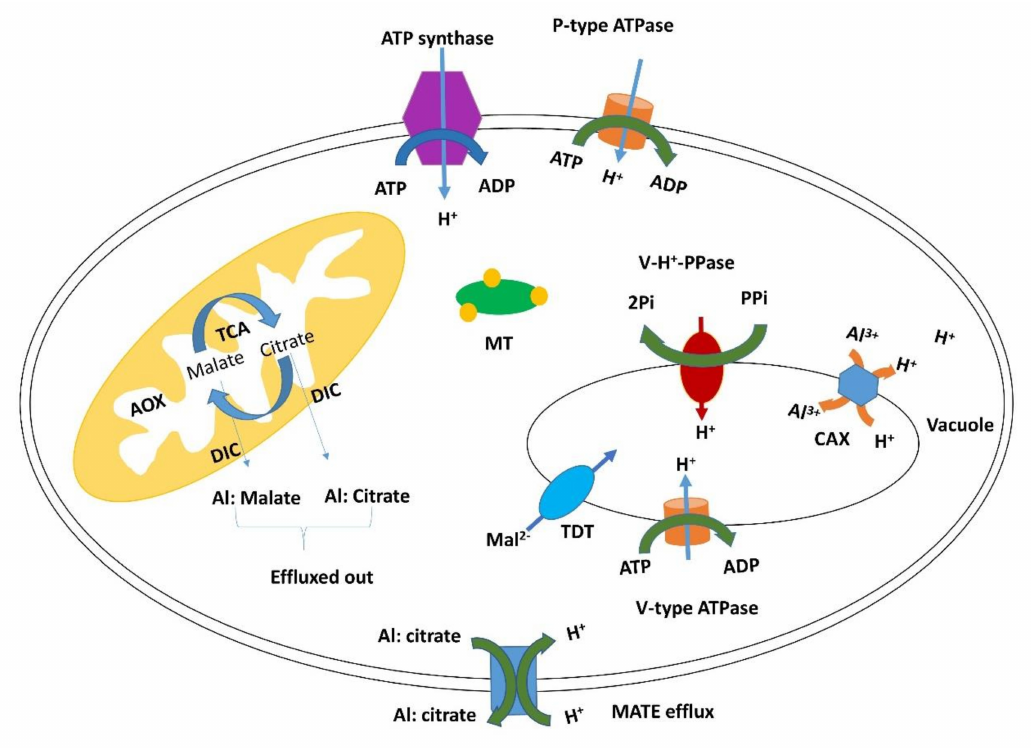
Figure 7. Detoxification mechanism used by TAS cultivar under aluminum